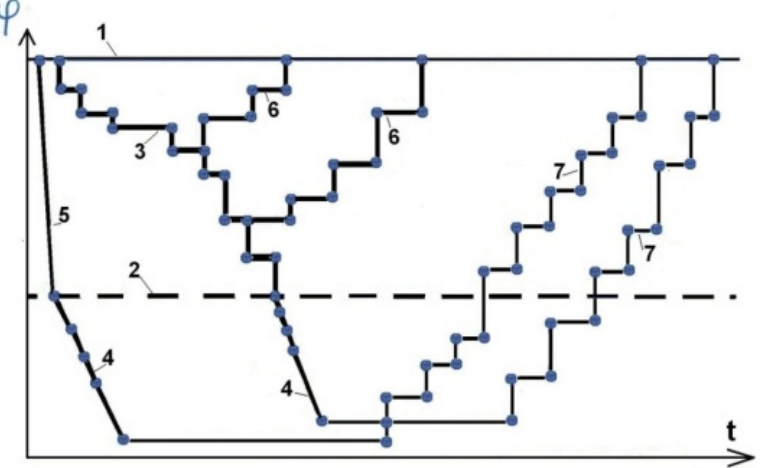
Figure 6. Illustration of EPS behavior in terms of survivability [43,44].